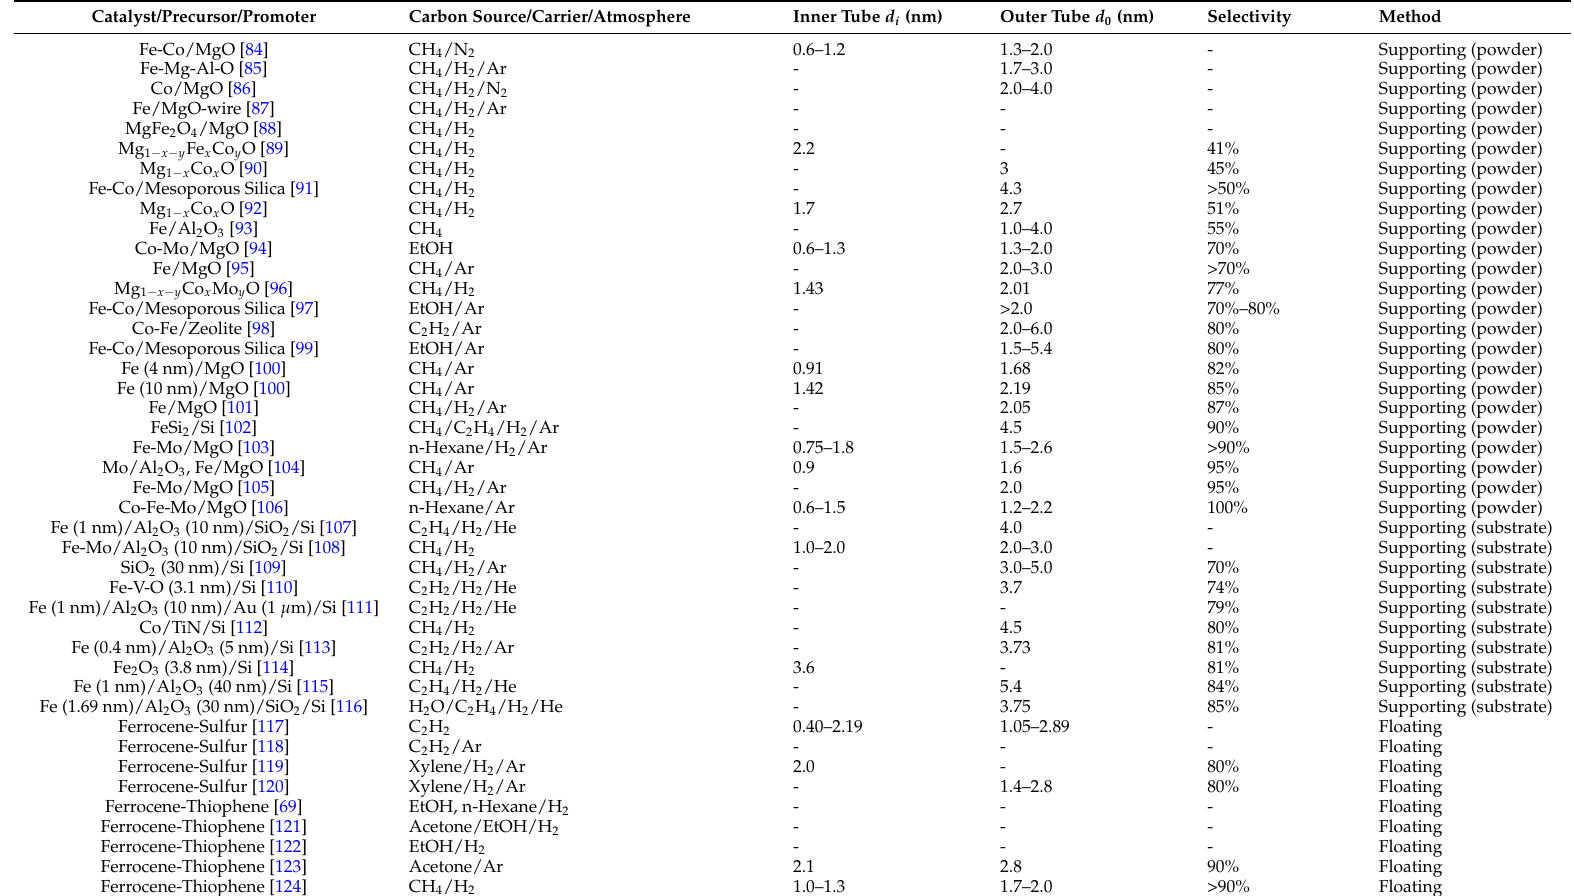
Table 1. Synthesis methods for the selective growth of double-walled carbon nanotubes